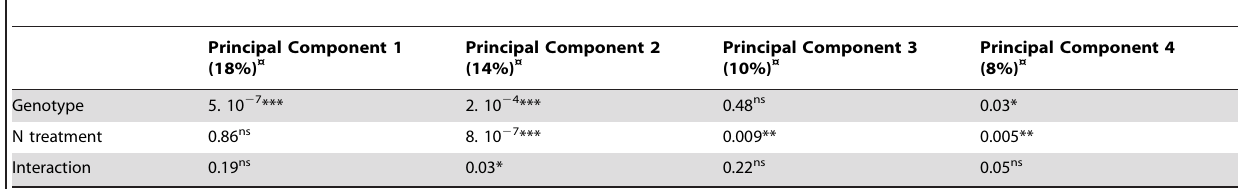
Table 2. Summary of statistical analysis (2-factor ANOVA) comparing the effect of genotype and N availability on the genetic structure of the rhizosphere bacterial communities.